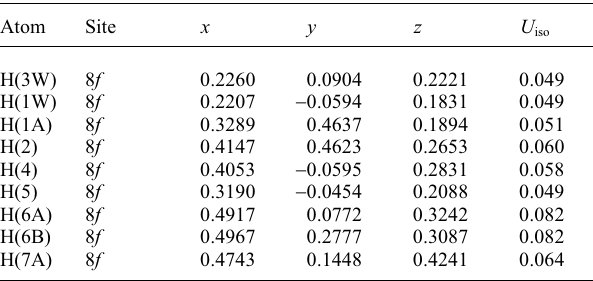
Table 2. Atomic coordinates and displacement parameters (in Å 2 )